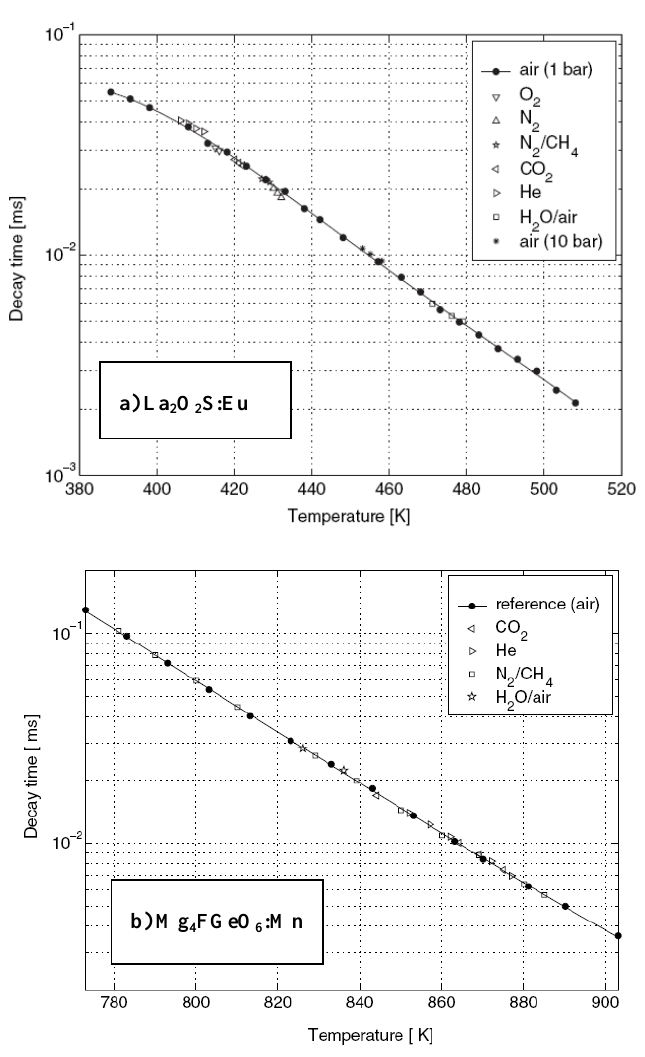
Effects of different gases on the lifetime decay of different phosphors